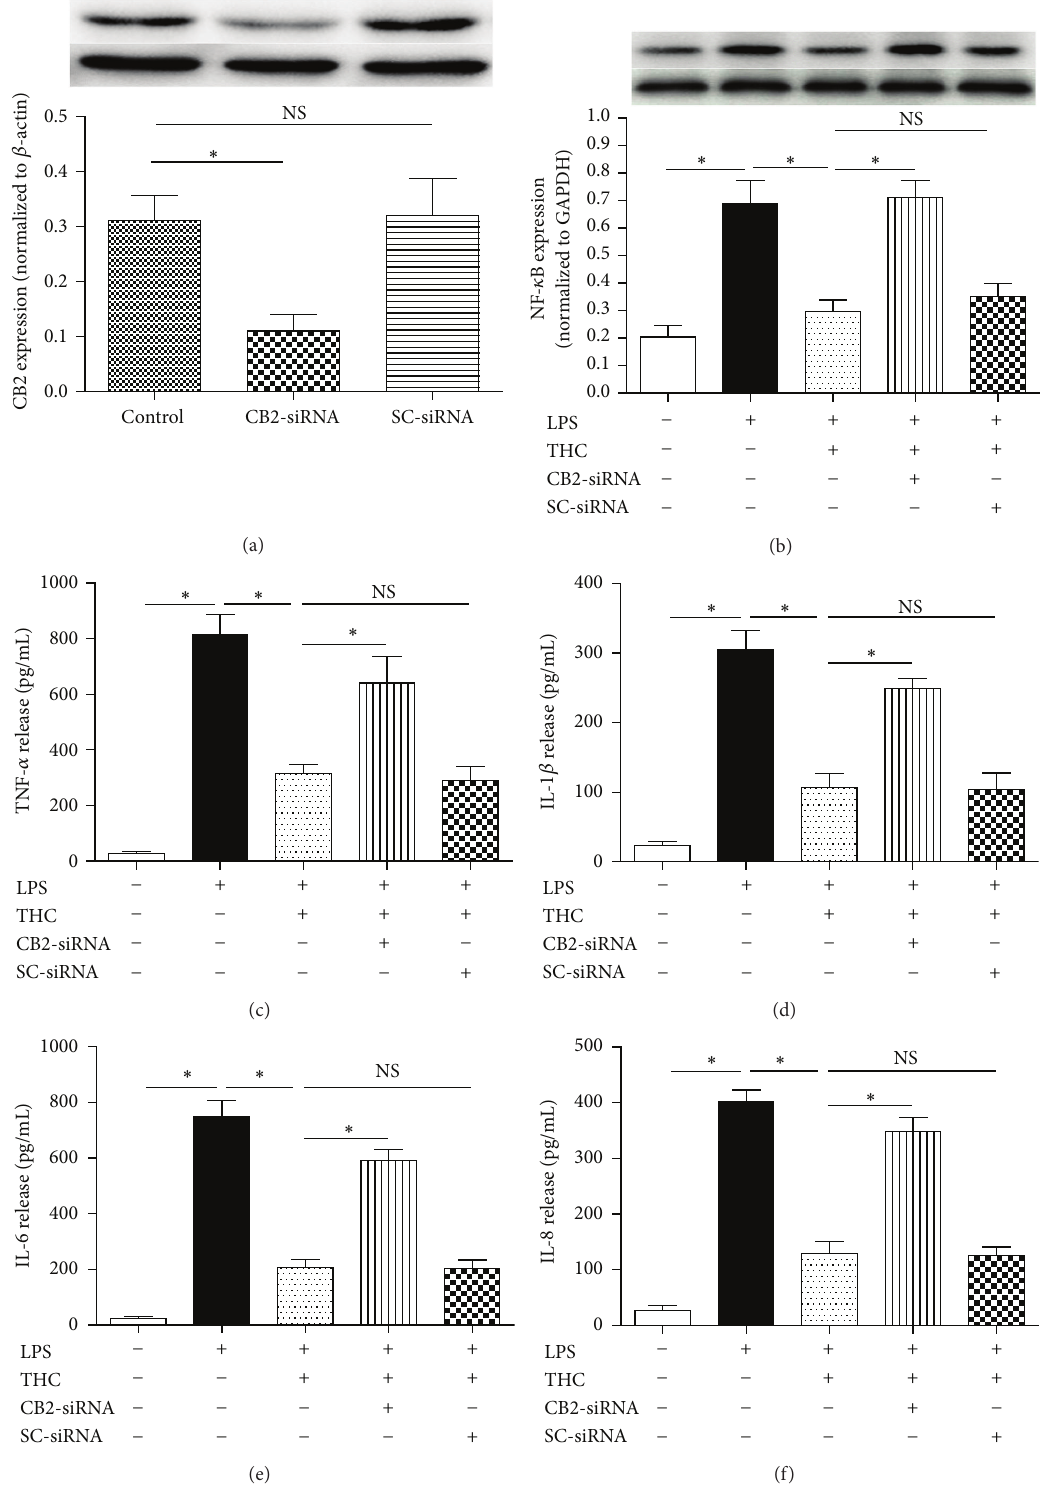
Figure 6: CB2-siRNA reversed THC-induced decrease of inflammatory factors release. MG-63 cells were assigned into five groups, control (no LPS, THC, or siRNA): cultured in drug-free medium; LPS: cells exposed to 10 ng/mL LPS for 24 h; THC + LPS: cells exposed to 5 𝜇 M THC plus 10ng/mL LPS for 24 h; CB2-siRNA + THC + LPS: cells incubated with CB2-siRNA for 24 h and then exposed to 5 𝜇 M THC plus 10ng/mL LPS for 24 h; scrambled siRNA (SC-siRNA) + THC + LPS: cells incubated with SC-siRNA for 24 h and then exposed to 5 𝜇 M THC plus 10 ng/mL LPS for 24h. (a) CB2-siRNA significantly downregulated the expression of CB2 receptor, assessed by western blot ( 𝑛 = 3 ). (b) CB2-siRNA significantly reversed THC-induced effect on NF- 𝜅 B expression ( 𝑛 = 6 ). (c)–(f) CB2-siRNA significantly reversed THC-induced effects on the release of TNF- 𝛼 , IL-1 𝛽 , IL-6, and IL-8 ( 𝑛 = 6 ). Results are means ± SD. ∗ : 𝑃 < 0.05 ; NS: no